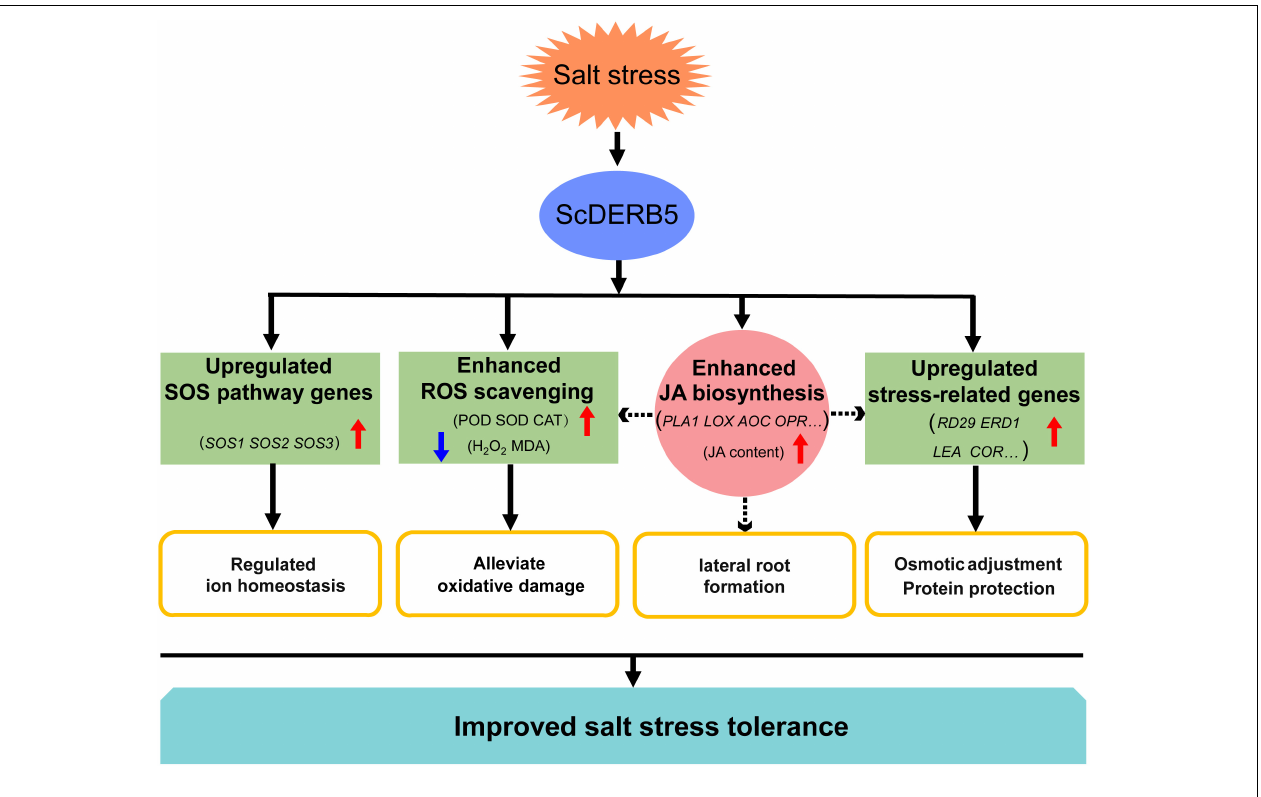
FIGURE 8 | The model of the ScDREB5 regulatory network involved in salt stress responses. Enhanced activities of antioxidant enzymes in the ScDREB5 -overexpression line resulting in decreased ROS accumulation, improving the expression of SOS pathway and stress-related genes, thus improving salt stress tolerances. ScDREB5 can activate the expression of JA biosynthesis related genes, modulating the JA content, thus improve salt stress tolerance in Arabidopsis. ↑ , ↓ indicate upregulation, downregulation,